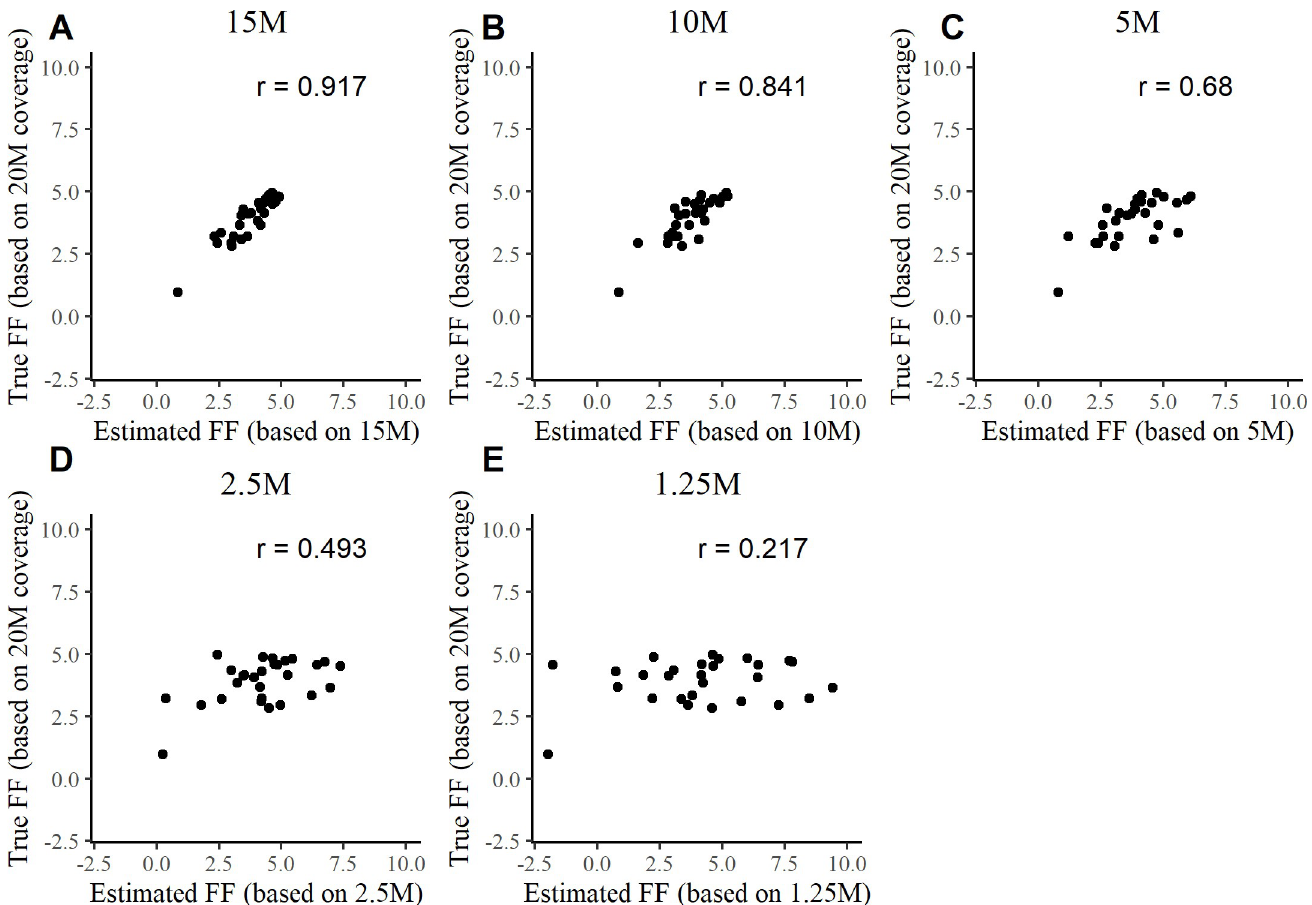
Fig 3. Correlation between the ‘true’ (based on 20M RPS data) and low sequencing depth based FF estimates. Pearson correlation data are shown for 20M RPS FF 0–5% estimates and estimates obtained at sequencing depths of 15M RPS (A), 10M RPS (B), 5M RPS (C), 2.5M RPS (D), and 1.25M RPS (E).